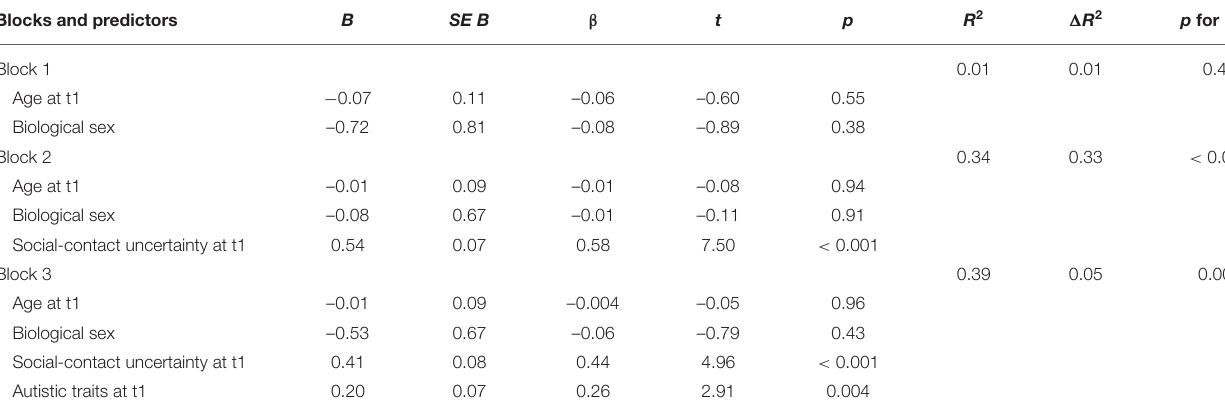
TABLE 2 | Hierarchical multiple regression analysis regressing social-contact uncertainty at t2. Blocks and